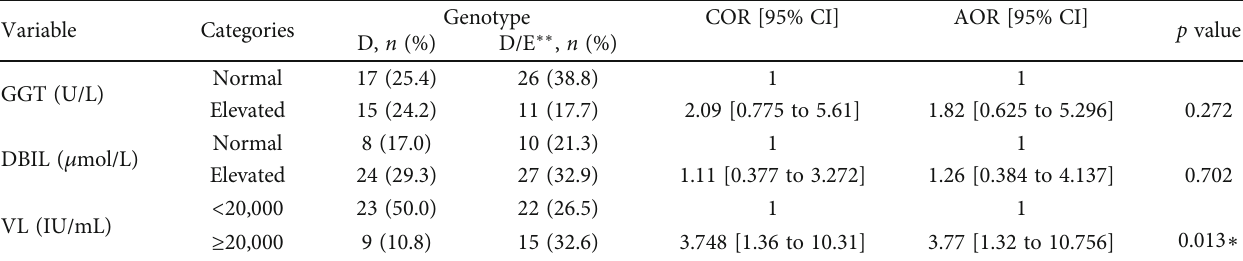
Table 7: Analysis of the variation in the levels of GGT, DBIL, and VL with genotype D using multinomial logistic regression